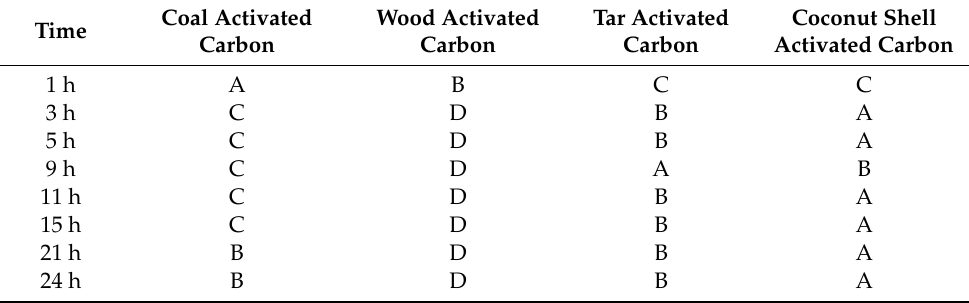
Table 2. Variance significance analysis of activated carbon types.